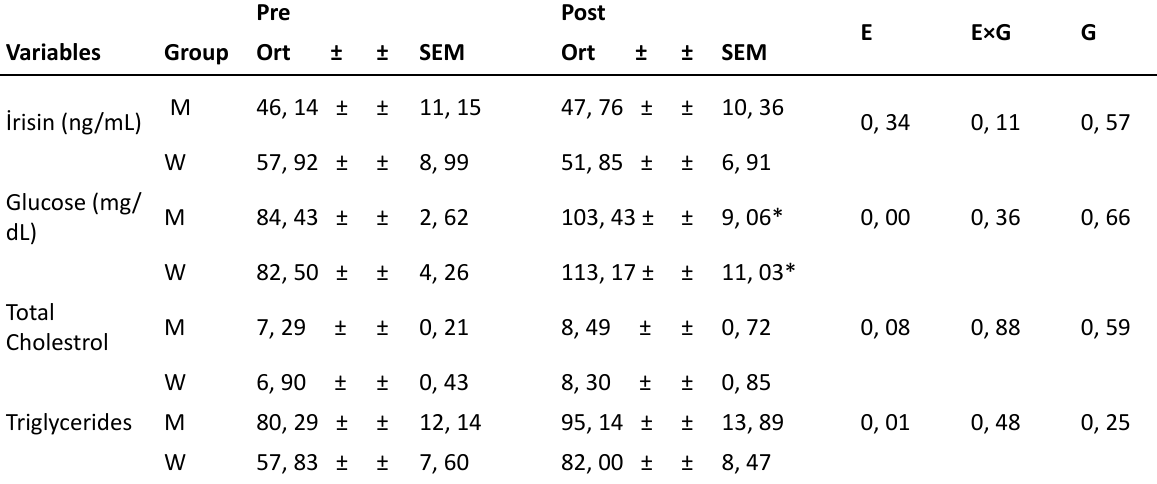
Table 2. Effect of gender and the training irisin and biochemical variables